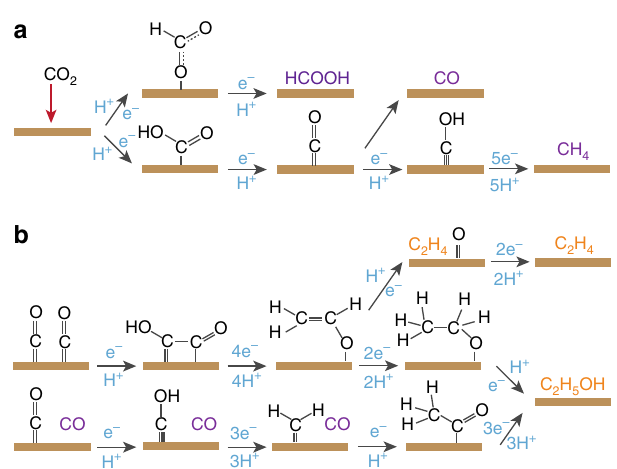
Fig. 3 Proposed mechanism for carbon dioxide electroreduction. a The pathway to C 1 products (formate, carbon monoxide, and methane) and b the pathway to C 2 products (ethylene and ethanol). Water molecules are not drawn and the formation of C 2 products is drawn from carbon monoxide. Purple color indicates a free C 1 molecule and orange color indicates a free C 2